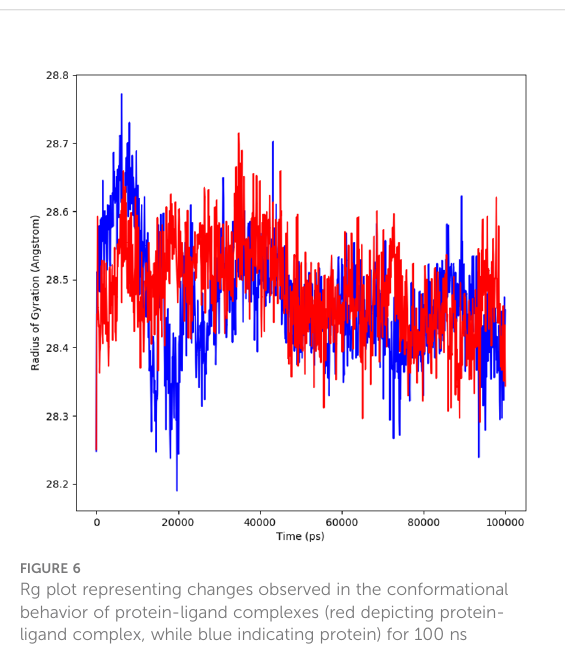
FIGURE 5 The graph displaying the RMSF values of C a atoms for 100 ns trajectories.